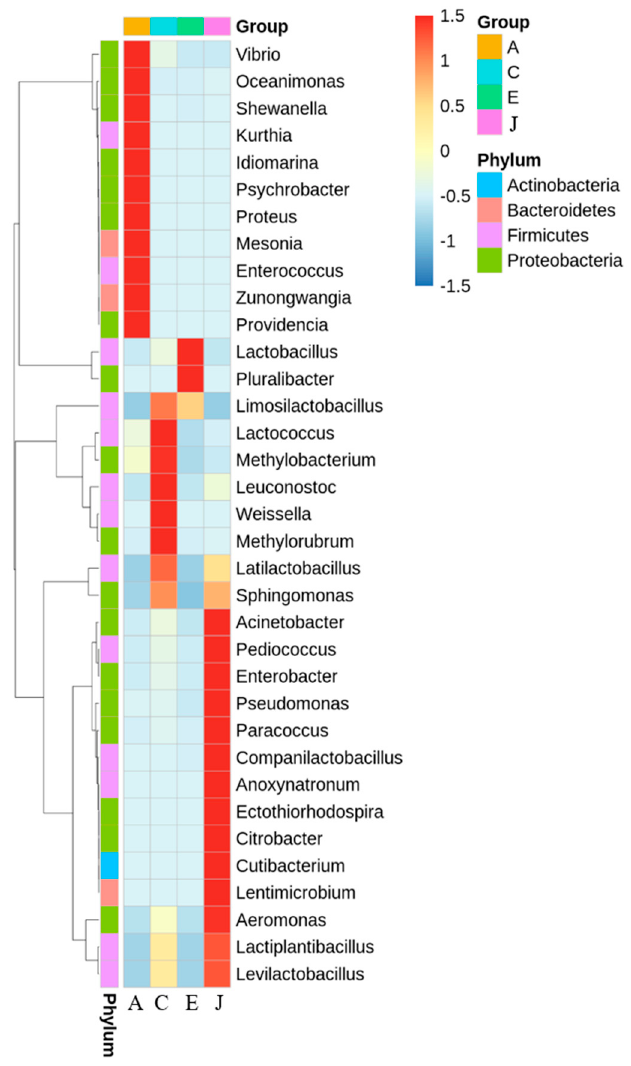
Figure 3. Heat map of microorganism species abundance of A, C, E, and J samples in retail market on genus level.